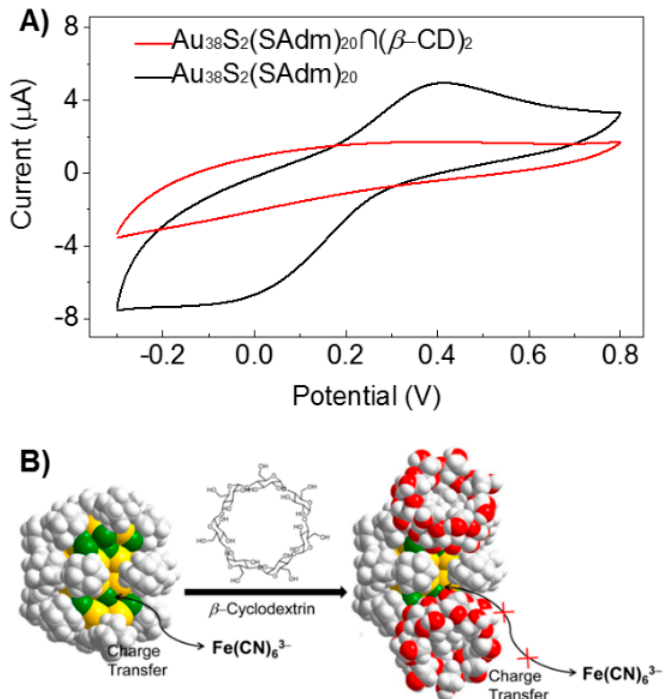
Figure 4. ( A ) Cyclic voltammograms (CV) for the redox reaction in potassium ferricyanide solution on Au 38 S 2 (SAdm) 20 clusters and Au 38 S 2 (SAdm) 20 -( β -CD) 2 conjugates. ( B ) Schematic illustrations of the Au 38 S 2 (SAdm) 20 -( β -CD) 2 formation and the charge transfer between Fe(CN) 63 − and the Au clusters and conjugates. Reproduced with permission from [38]. The Royal Society of Chemistry, 2016.